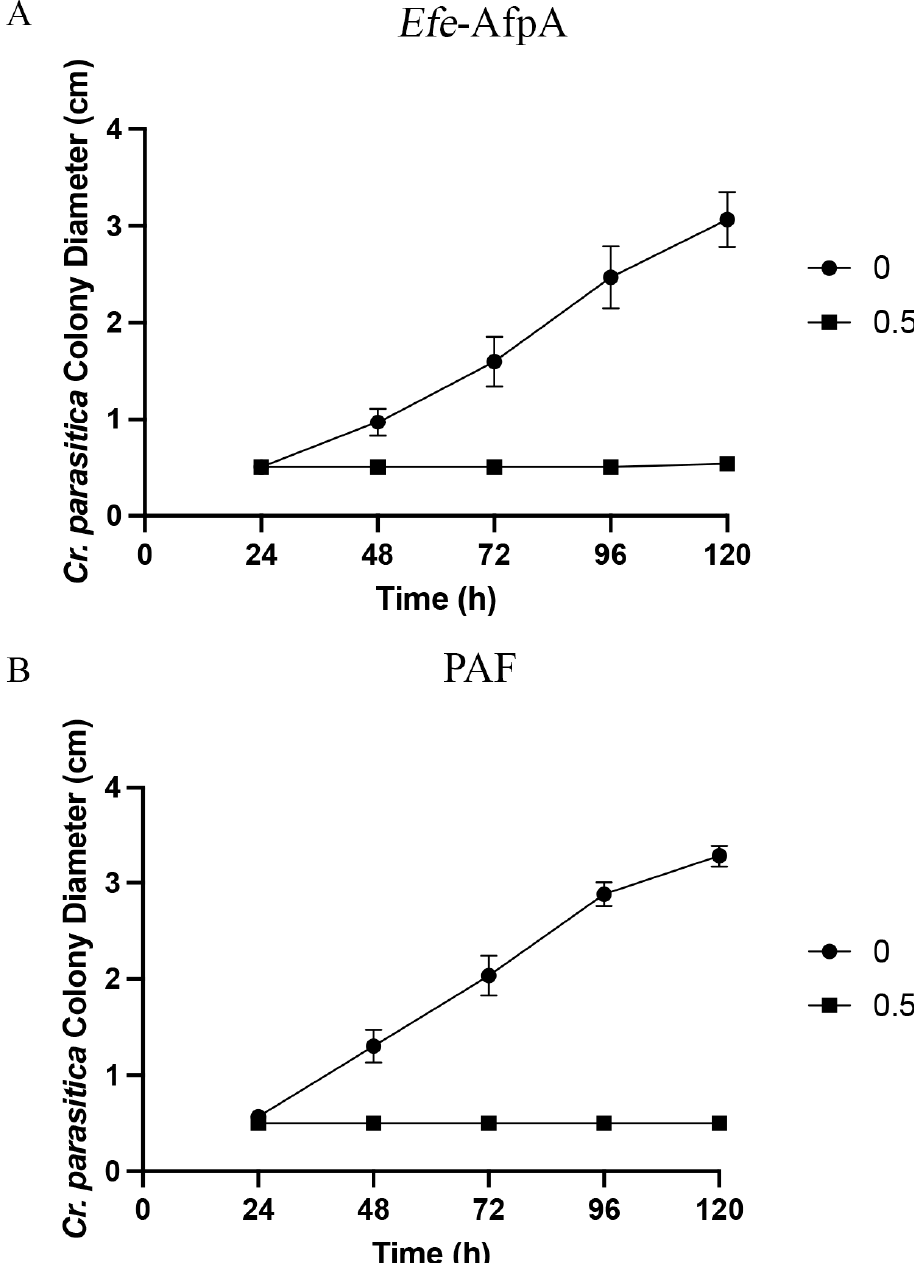
Figure 3. Activity of ( A ) Efe- AfpA and ( B ) PAF against Cr. parasitica mycelial growth. Cr.